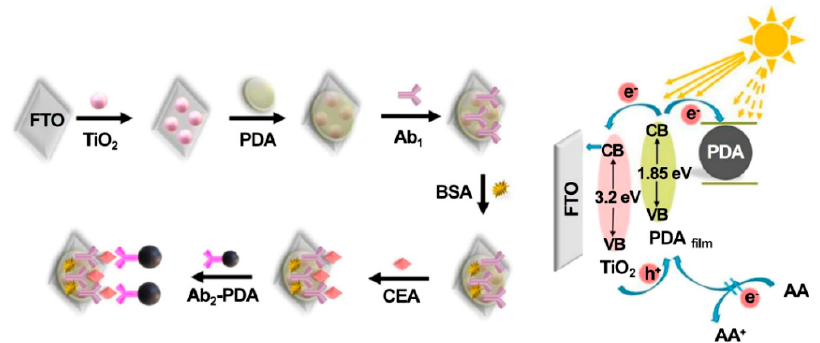
Figure 6. Fabrication and detection mechanism of the PEC immunosensor. Reprinted with permission from ref. [94]. Copyright 2021 American Chemical Society.